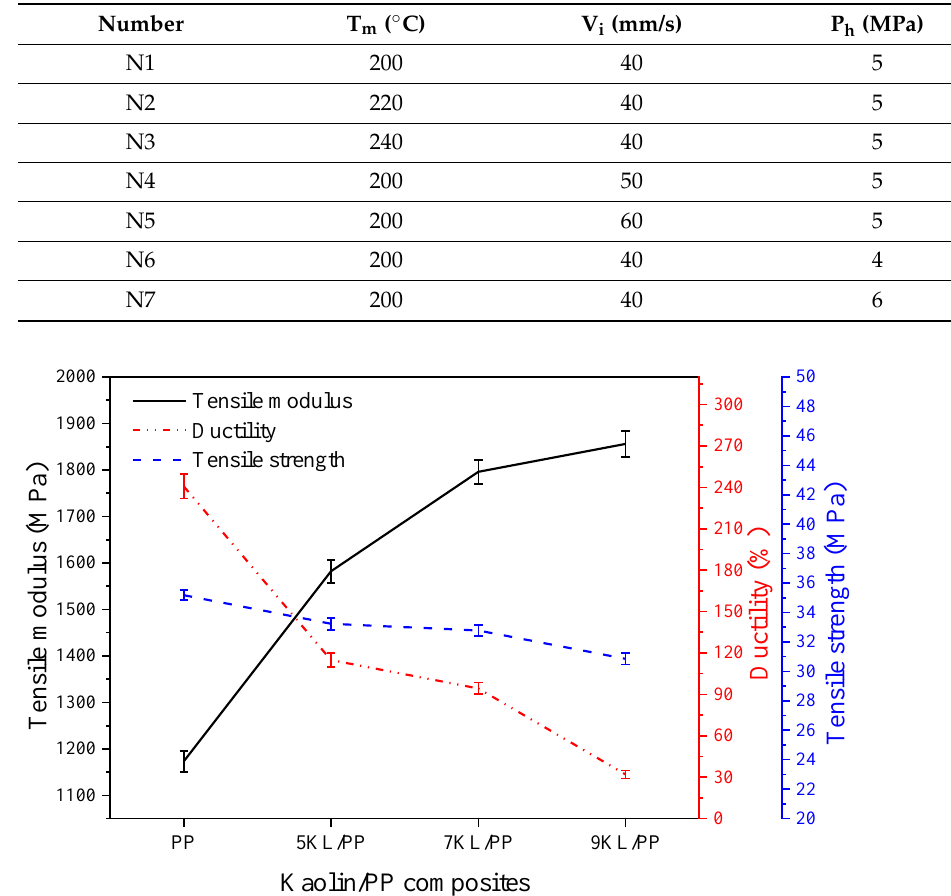
Figure 8. Mechanical properties of PP/kaolin composites.